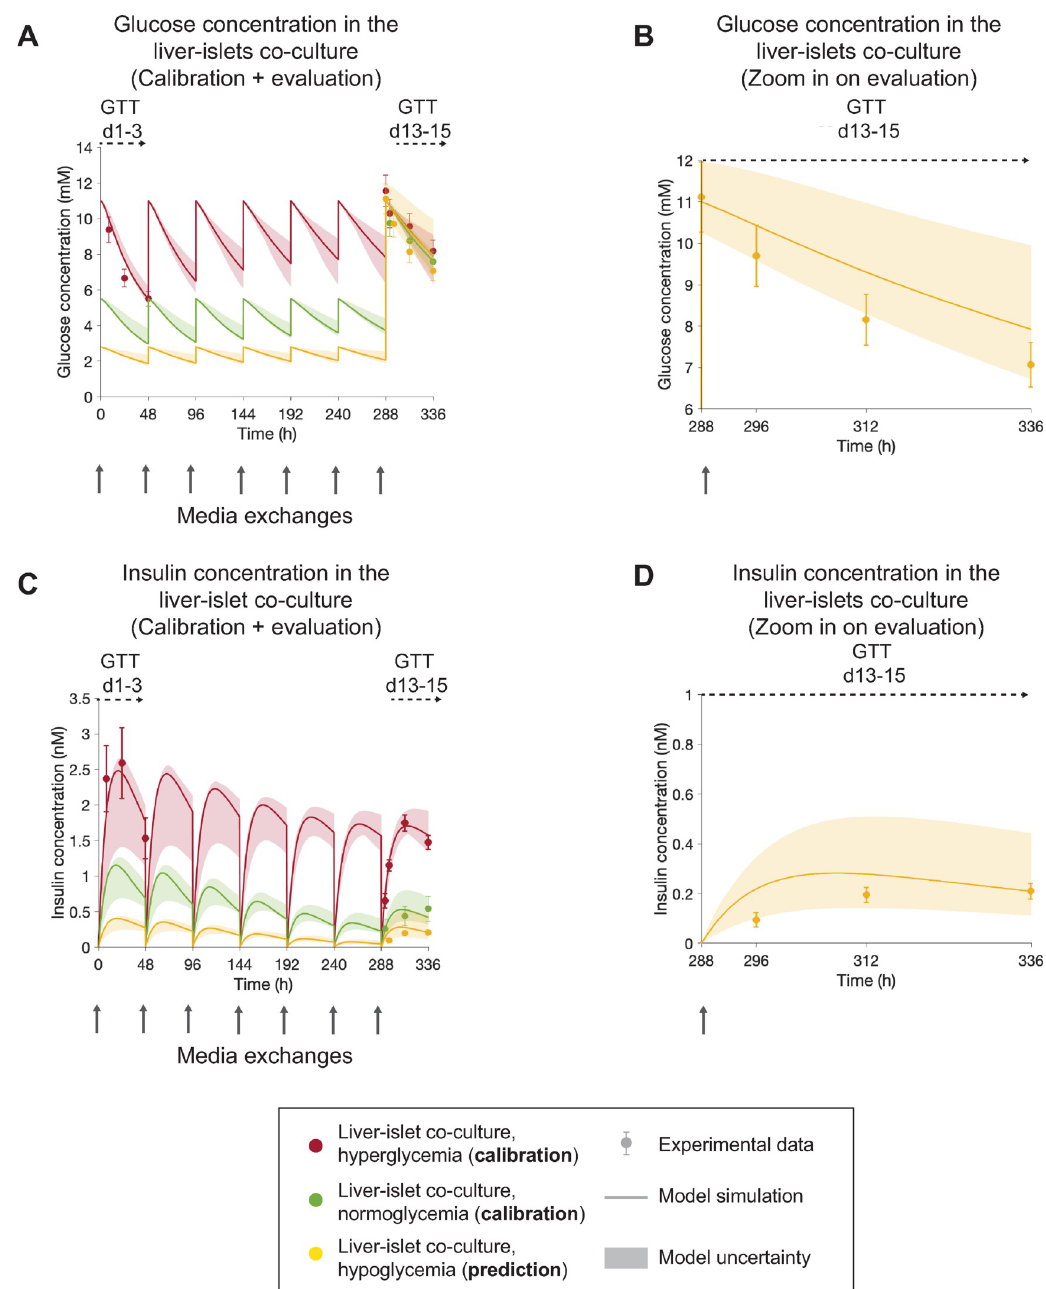
Fig 6. The model can predict GTT responses in the end of the liver-islet co-culture following repeated exposure to hypoglycemic media concentrations. The results correspond to a single experiment (experiment 3). In A,C, experimental measurements of glucose and insulin concentrations (markers) are compared to model simulations for hyper- and normo- glycemia (red and green, lines) and model predictions for hypoglycemia (yellow lines) over the 15 days of co-culture. Co-cultures were exposed to either a hyperglycemic (11 mM glucose, red), normoglycemic (5.5 mM glucose, green) and hypoglycemic (2.8 mM glucose, yellow) media in each media exchange (grey arrows) between days 1 and 13. Experimental time-series were acquired during GTTs initiated at day 1 (GTT d1-3) in hyperglycemic co-cultures and day 13 (GTT d13-15) in all co-cultures (hyper-, normo- and hypoglycemic). For a clearer comparison between the model predictions and the corresponding experimental data for the evaluation part, panels B and D zoom in on the GTT performed at day 13 for the hypoglycemic arm—glucose (B) and insulin (D) . Model uncertainty is depicted as shaded areas in A-D . Data in panels A,C are presented as mean ± SEM, n = 5. n: Number of platform replicates included in the